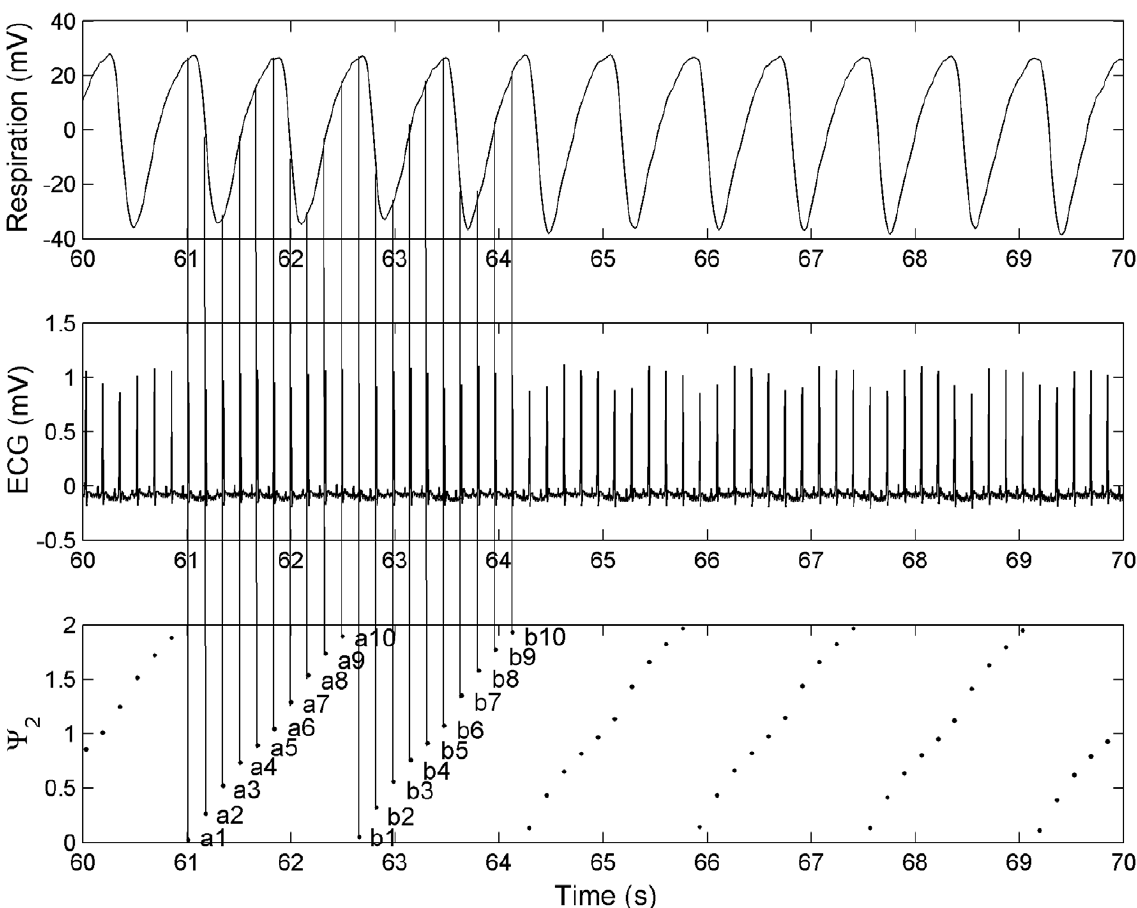
Figure 2. Illustration of the generation of synchrogram from the respiratory and ECG signals. a1, a2,…,a10 and b1, b2,….,b10 in the synchrogram plot represent the respiratory phases, based on the time points of R-peaks, for the first two and the following two respiratory cycles.